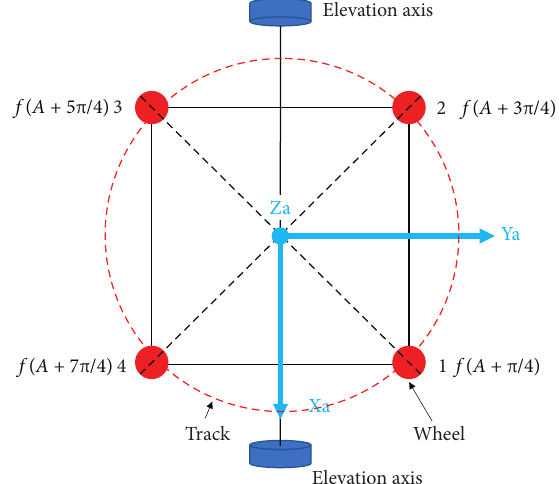
Figure 4: The sketch of the four-support-point telescope